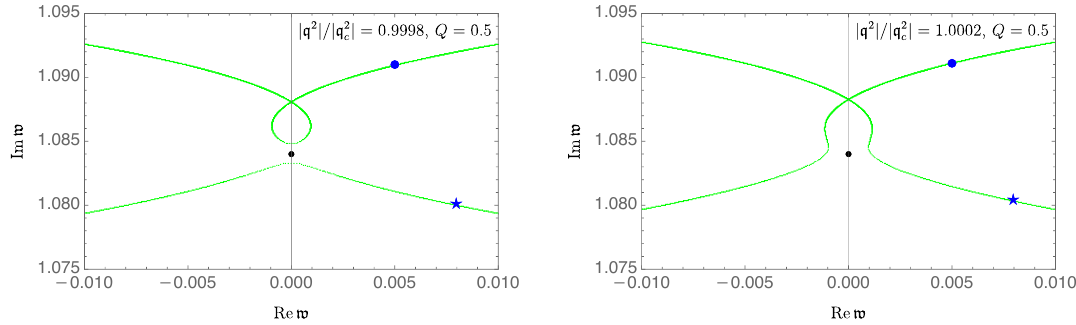
Figure 17. Fine structure geometry of the second collision point in the spin 0 channel at Q = 0 : 5, in the complex w (cid:0) plane, at various values of the complexi(cid:12)ed momentum q 2 = j q 2 j e i(cid:18) . When the phase (cid:18) increases from (cid:24) 0 : 495 (cid:25) to (cid:24) 0 : 505 (cid:25) , blue dot and star poles lying on the green trajectories move from right to left along them. The left panel shows the situation slightly before the collision occurs. The collision point is marked with a black dot. The right panel corresponds to a value of j q 2 j slightly greater than that at which the two poles